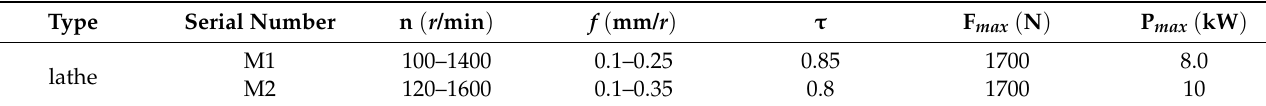
Table 2. Machine parameters.